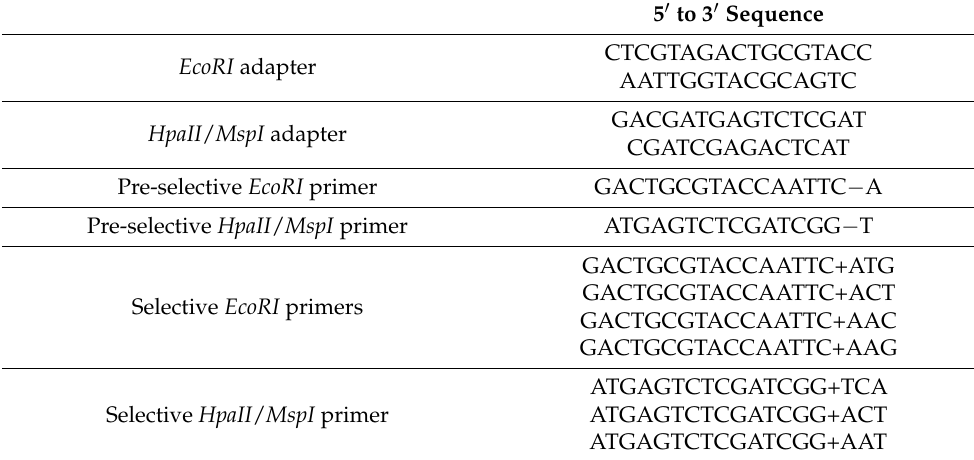
Table 1. Adapters and Primers used for the MSAP